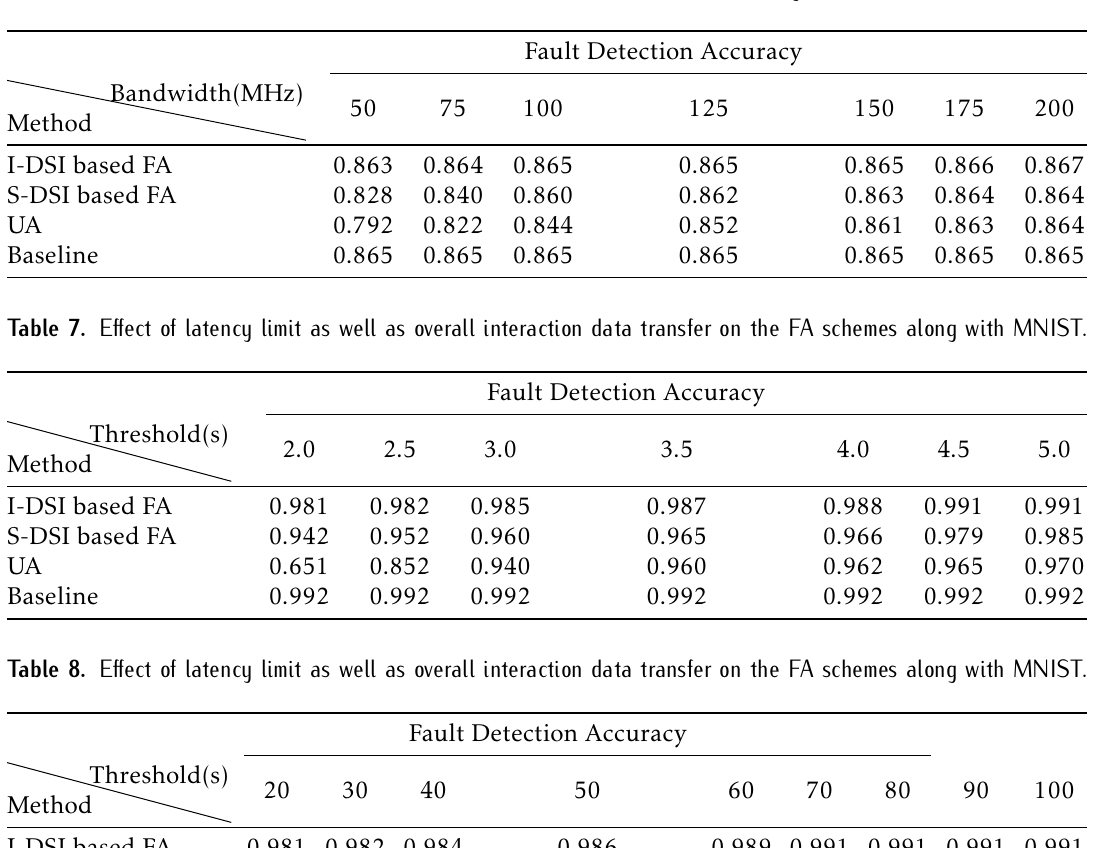
Table 6. Effect of overall interaction data transfer on the FA schemes along with Fashion-MNIST.